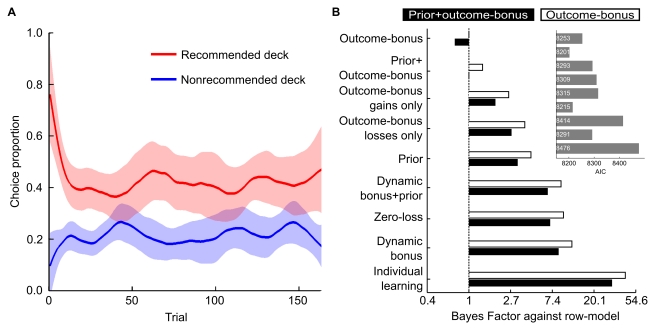
Behavioral and modeling results.(A) Participants' average choice proportions (running average of 11 trials ±2 standard errors) for the recommended and the non-recommended corresponding deck. This sustained influence of advice is consistent with the outcome-bonus mechanism, but not with the assumption that advice influences only the evaluation of choice options prior to individual learning (see below for detailed description of the social learning models). (B) The panel shows Bayes factors comparing the two models with the lowest Bayesian information criterion (outcome-bonus model and prior+outcome-bonus model) with the other models. The Bayes factor shows how much more likely the two best models are as compared to the model in the respective row. For instance, the last row shows that the prior+outcome-bonus model is about 30 times and the outcome-bonus model is about 40 times more likely than the individual learning model. Models assuming the influence of advice on evaluation of either gains or losses performed worse than the original outcome-bonus model. Moreover, more complex models implementing a dynamic outcome-bonus do not predict the data better than the simpler models with stable outcome-bonus. The inset (same order of models on the x-axis) shows that these results also hold when using the Akaike information criterion (AIC) as a model selection criterion. Because the AIC imposes smaller penalties for additional free parameters (for our sample size), models with a dynamic outcome-bonus perform better according to the AIC criterion. In sum, regardless of the model selection criterion, an outcome-bonus and a prior mechanism are implemented in the best models, but a dynamic or payoff-selective outcome-bonus mechanism is not.